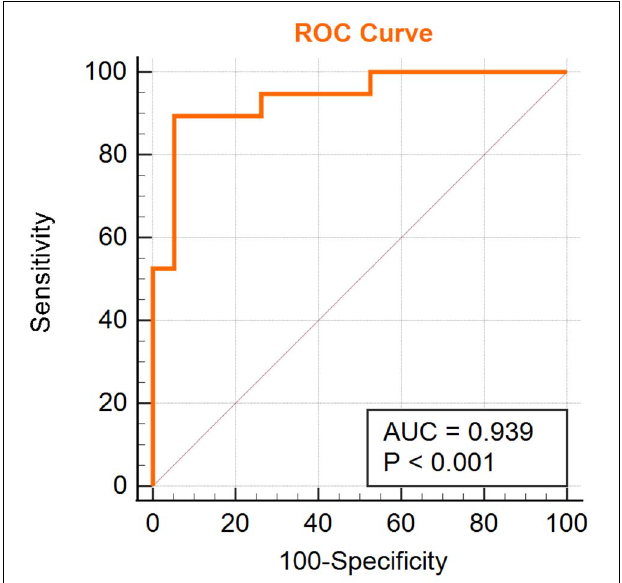
FIGURE 2 | ROC curve of the classifier.